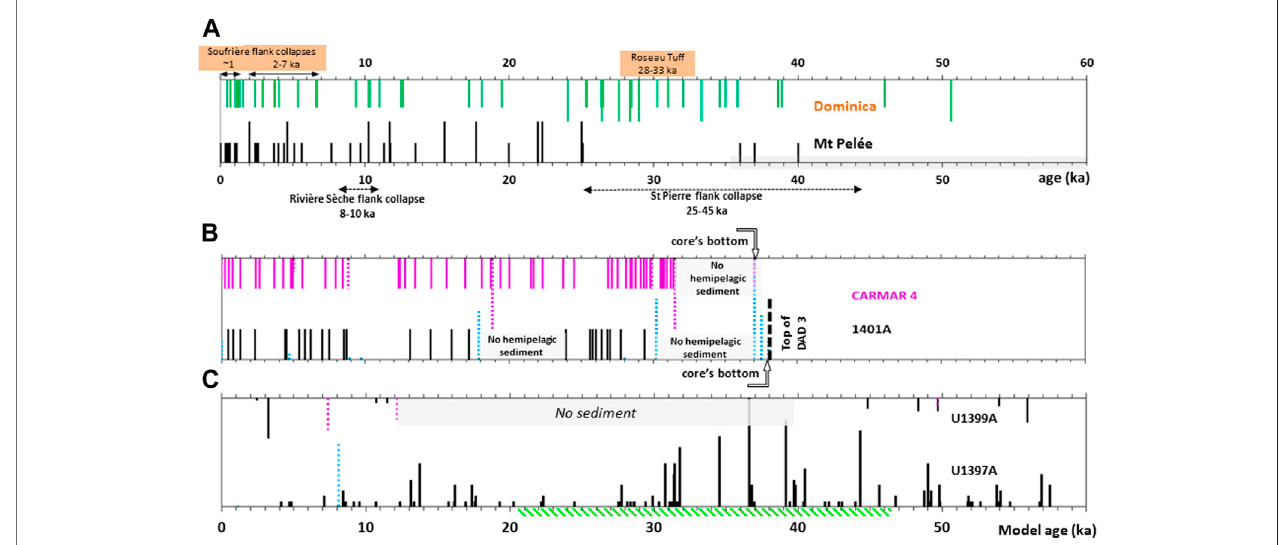
FIGURE 9 | Volcanic records on land (Mt Pelée and Dominica) and in cores U1397A, U1399A, U1401A, and CARMAR 4: 0 – 60 ka. (A) On-land dating. Data sources: 1) Dominica: fl ank collapses Soufrière ( 14 C; Le Friant et al., 2002), Plat Pays (K-Ar; Samper et al., 2008), and eruptions ( 14 C, Carey and Sigurdsson, 1980, Lindsay et al., 2005, Boudon et al., 2017; U-Th/He Howe et al., 2014). 2) Mt Pelée: fl ank collapses: “ Le Prêcheur ” and “ St Pierre ” (K-Ar, Germa et al., 2011a), “ Rivière Sèche ” and “ St Pierre ” (U-Th, Le Friant et al., 2002, Le Friant et al., 2015 and Villemant, unpublished; 14 C, Westercamp et al., 1989 and Boudon et al., 2013). Eruptions ages: most 14 C dates for Mt Pelée are relatively old measurements by bêta counting (gray zone: all ages out of 14 C dating range; Traineau et al., 1989); recent 14 C data: Michaud-Dubuy et al., 2019; others: K-Ar, Germa et al., 2011a; U-Th, Le Friant et al., 2002 and Villemant, unpublished. Age ranges of fl ank collapses are estimatedusingbracketingagesofpre-andpost- fl ankcollapsedome-formingeruptions(seealso Figure2 ).Theheightofthebarsrelatestotherelativeintensitiesofthe eruptions (on-land data). (B) Cores U1401 A and CARMAR – 4 (from Solaro et al. (2020) and Boudon et al. (2013), modi fi ed). Lines: tephra; dotted lines: turbidites (the height of the bars relates to the relative thicknesses of the turbidites). Gray domains: hemipelagic sedimentation gaps. Thick dashed line: end of core U1401A on top of the most recent DAD offshore Mt Pelée (DAD3; see Figure 1 ); its age of ~36 ka (minimum value, Solaro et al., 2020) is still questioned (see text for explanations). (C) : Cores U1397A and U1399A (this study). Tephra (lines) and turbidites (dotted lines) are represented with their relative thicknesses. Gray domain: sedimentation gap between 12 and 40 ka (U1399A). The green dashed domain (~20 – 47 ka) corresponds to the presence of large fractions of ma fi c scoriae in core U1397A (Del Manzo et al., in prep.). Scales are arbitrary and different for tephra layers, turbidites, and